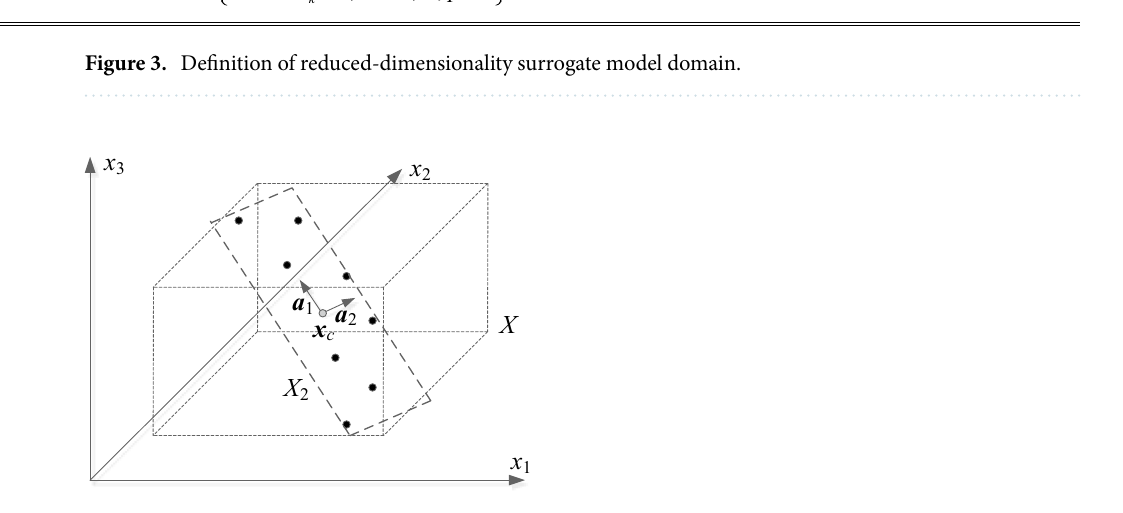
Figure 4. Conceptual illustration of reduced-dimensionality surrogate model domain. Here, a two-dimensional domain X 2 spanned by the two most dominant eigenvectors a 1 and a 2 ; the gray circle represents the center point x c (cf. Figure